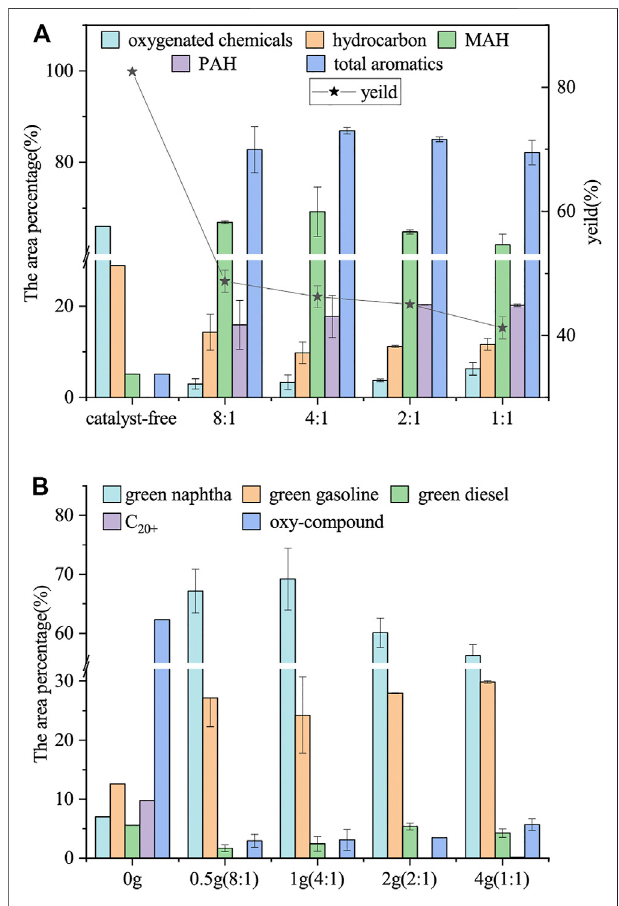
FIGURE 5 | Effect of the feedstock-to-catalyst ratio on bio-oil. (A) Area percentageofthebio-oilcontainingoxy-compound, hydrocarbon(alkeneand alkane), MAH, PAH, the total aromatics, and the bio-oil yield; (B) area percentage of oxy-compound, C 20+ hydrocarbons, green diesel (C 13 – C 20 ), green gasoline (C 10 – C 12 ), and green naphtha (C 5 – C 9 ) in bio-oil.